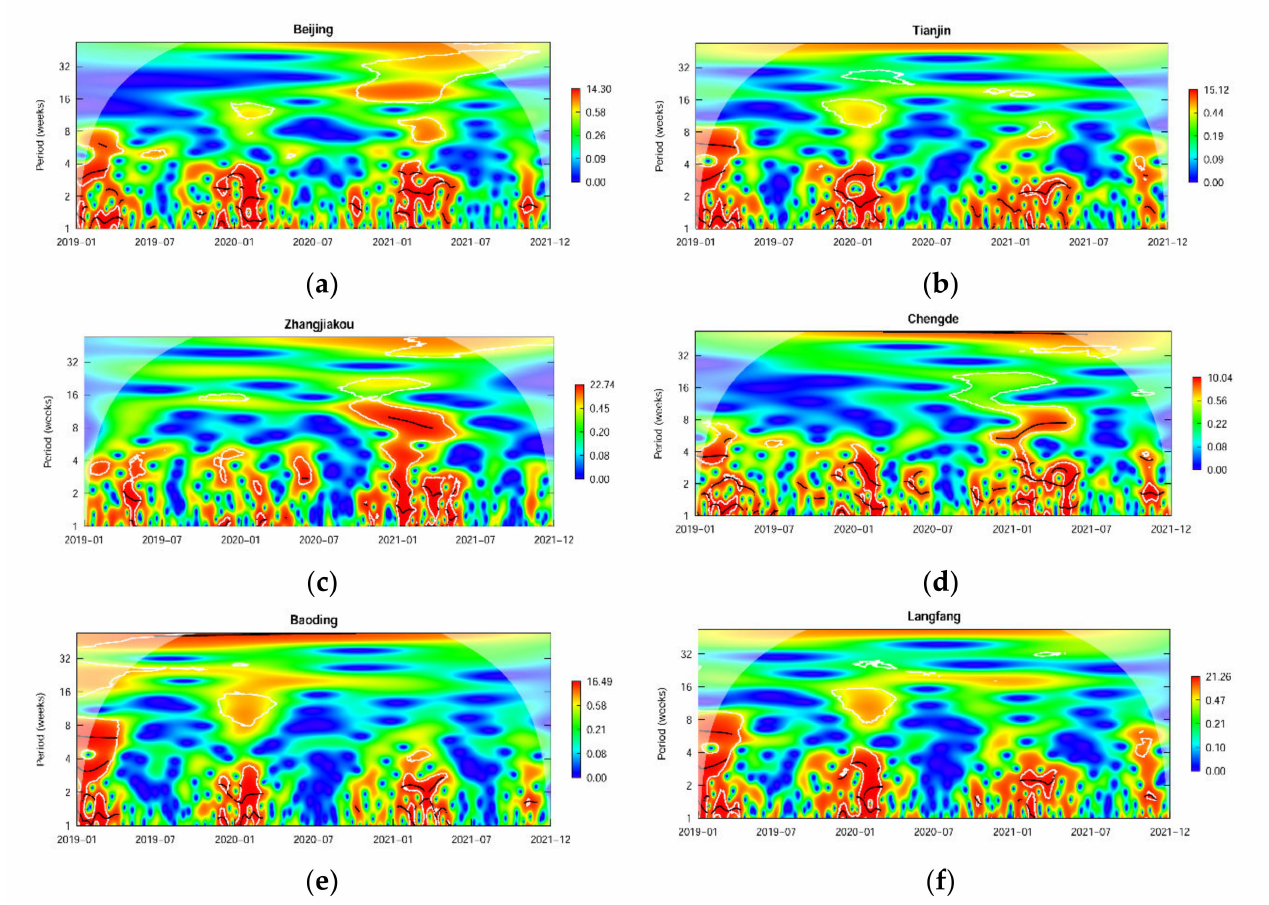
Figure 4. Results of periodic variation characteristics of AQI of Beijing and its neighboring cities. Note: the horizontal axis is time and the vertical axis is the periodicity length in weeks. The wavelet power spectrum is represented by the change from blue (low power) to red (high power). The black lines show the maxima of the undulations of the wavelet power spectrum. The white shade contour designates the cone of influence, which indicates the region affected by edge effects. The white contour inside the white shade contour marks the 5% significance level estimated from Monte Carlo simulations. ( a ) Beijing. ( b ) Tianjin. ( c ) Zhangjiakou. ( d ) Chengde. ( e ) Baoding. ( f )